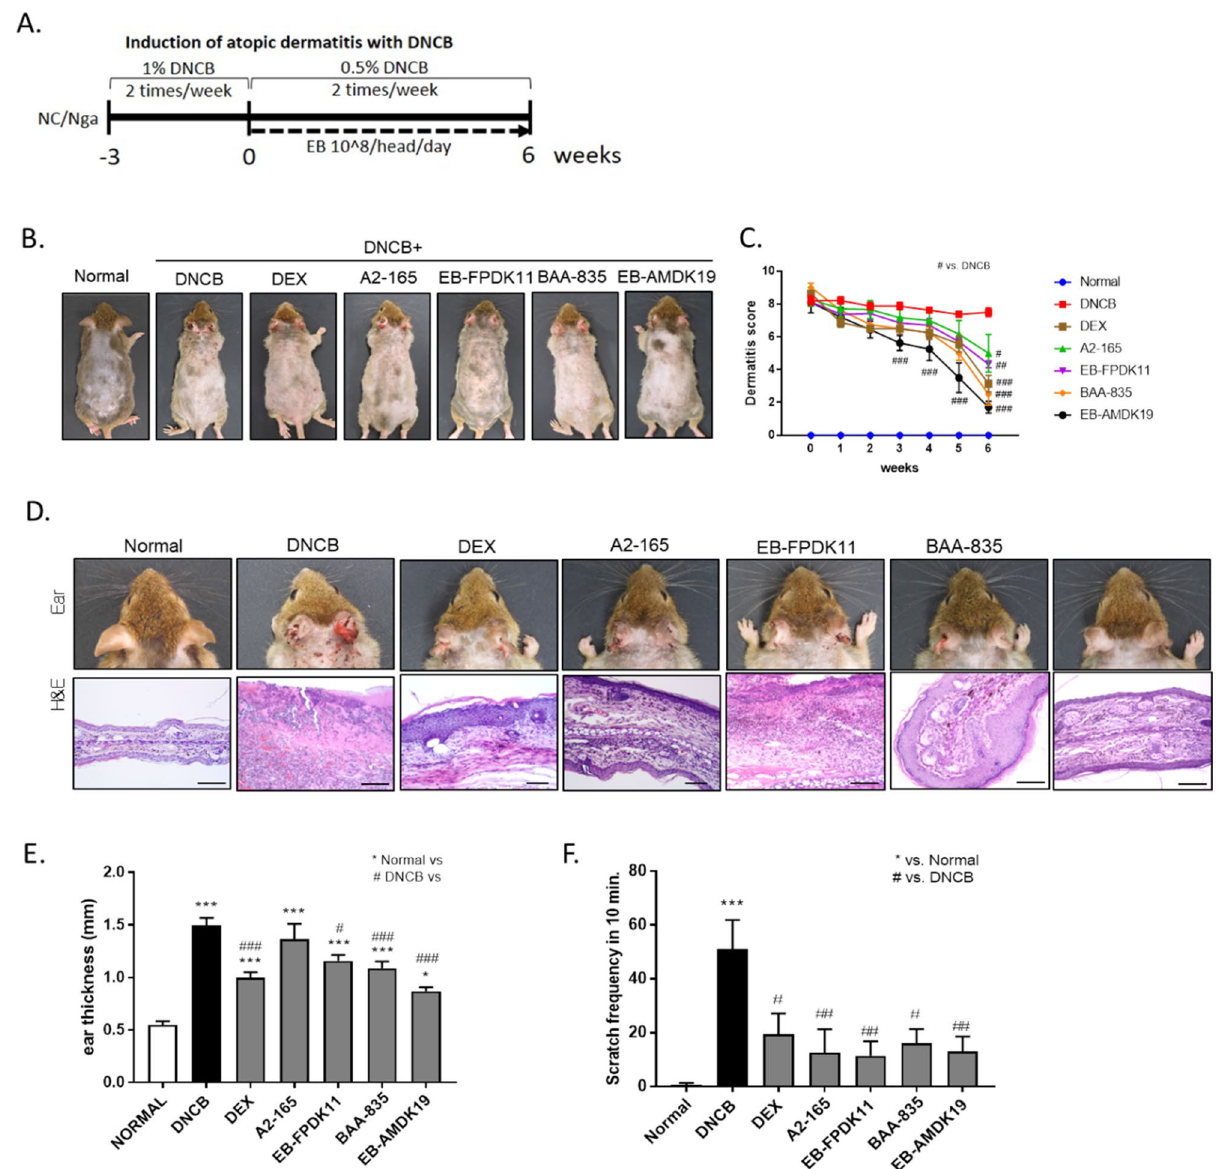
Figure 1. EB-FPDK11 and EB-AMDK19 efficiently prevent the symptoms of AD-like lesion in NC/Nga mice. ( A ) Schematic diagram of the study protocol. ( B ) Photograph of the dorsal skin lesions. ( C ) Dermatitis score were evaluated weekly. ( D ) Photograph and H&E staining of the ear skin lesions from groups, scale bar: 0.1 mm. ( E ) Ear thickness was measured. ( F ) Scratch behavior of the mice was observed for 10 min after sensitization. * P < 0.05; ** P < 0.01; *** P < 0.001; *versus normal group; # versus DNCB with DNCB caused the development of severe dermatitis, scoring approximately 8 in all the experimental groups (Fig. 1B, C). Hardly any changes in the dermatitis score during the 6-week treatment period were observed in the DNCB group, while the scores of the groups receiving dexamethasone or the respective bacterial strains at a daily dose of 10 8 CFUs significantly decreased compared with the DNCB group (DEX: 51%, P < 0.001; A2-165: 32%, P < 0.05; EB-FPDK11: 34%, P < 0.01; BAA-835: 53%, P < 0.001; EB-AMDK19: 69%, P < 0.001). Histologically, DEX, EB-FPDK11, BAA-835, and EB-AMDK19 administration largely attenuated the patho- logic changes in the ear skin lesions, such as hyperkeratosis and inflammatory cell infiltration, compared with the DNCB group, but there were no apparent changes in the A2-165 group (Fig. 1D). Similarly, significant reductions in ear thickness were observed in the treatment groups, except for the A2-165 group (normal: 0.55 ± 0.03 mm, DNCB: 1.50 ± 0.07 mm, EB-FPDK11: 1.16 ± 0.06 mm, P < 0.05; BAA-835: 1.1 ± 0.06 mm, P < 0.001; EB-AMDK19: 0.87 ± 0.04 mm, P < 0.001 compared with the DNCB group) (Fig. 1E). Meanwhile, scratching behavior was counted to assess the effects on itchy skin. The repeated topical application of DNCB resulted in a 7.5-fold- increase in scratching behavior in the normal group ( P < 0.001) (Fig. 1F). In contrast, scratching behavior was